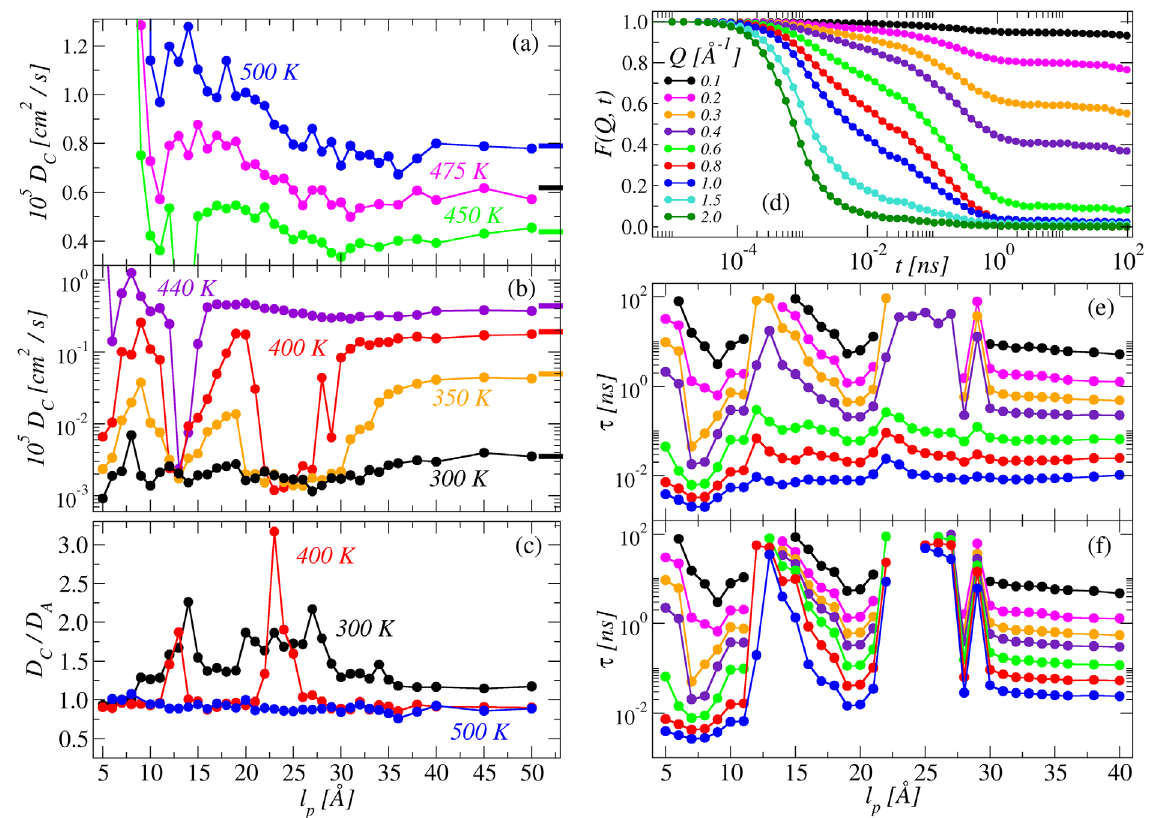
FIG. 5. Details of the dynamics. (a) l dependence of the diffusion coefficients of the cations ’ centers of mass D p temperature values. The corresponding values in the bulk are indicated by the solid thick lines on the right. (b) Same as in (a) at the indicated lower values of temperature. The deep discontinuities corresponding to phase-boundary crossing are discussed in the main text. =D (c) The ratios D of the diffusion coefficients of the cations over those of the anions at the indicated temperatures. (d) Intermediate C A Q; t Þ at the indicated values of Q and T ¼ 400 K. The data are calculated for the cations ’ centers of mass. In (e) scattering functions F s ð and (f), we plot the relaxation times τ ð Q Þ for cations and anions, respectively, calculated from the relation F identifying different values of Q are the same as in panel (d). These data show that, for particular values of l anions decouples, the latter falling out of equilibrium on the timescale of our simulation, at all investigated values of Q